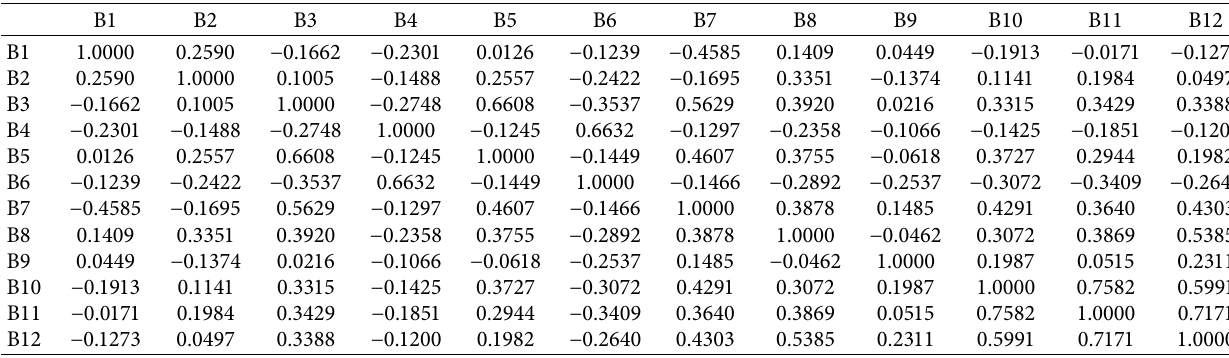
Table 7: Symmetric matrix.